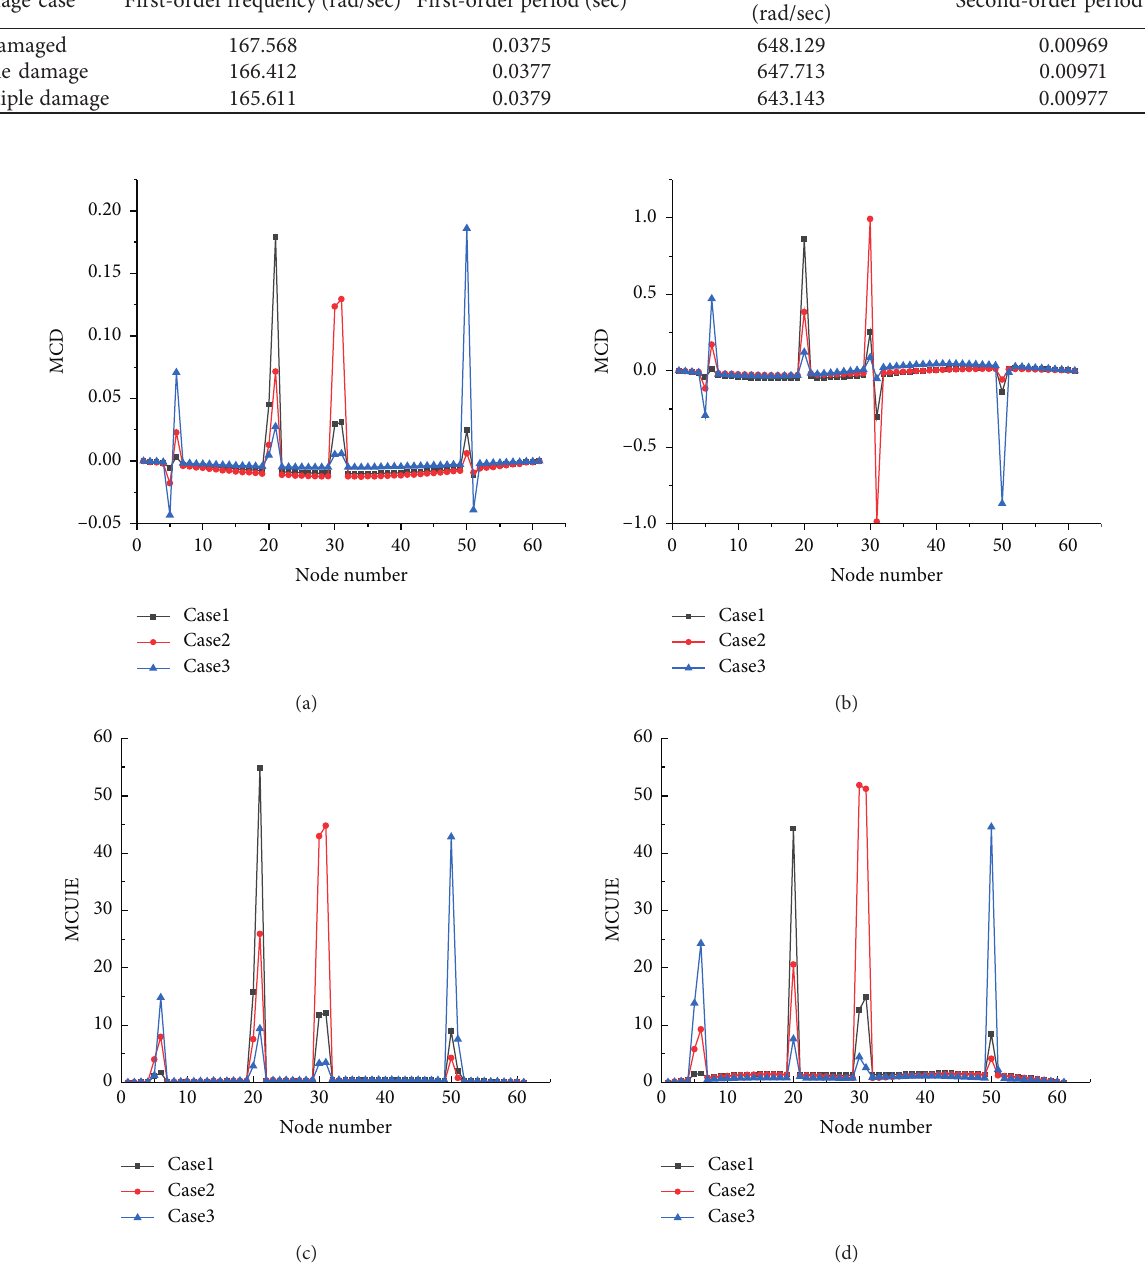
Figure 11: Damage identification results of MCD and MCIUE index of case studies 1–3. (a) First-order MCD. (b) Second-order MCD. (c) First-order MCUIE. (d) Second-order MCUIE.